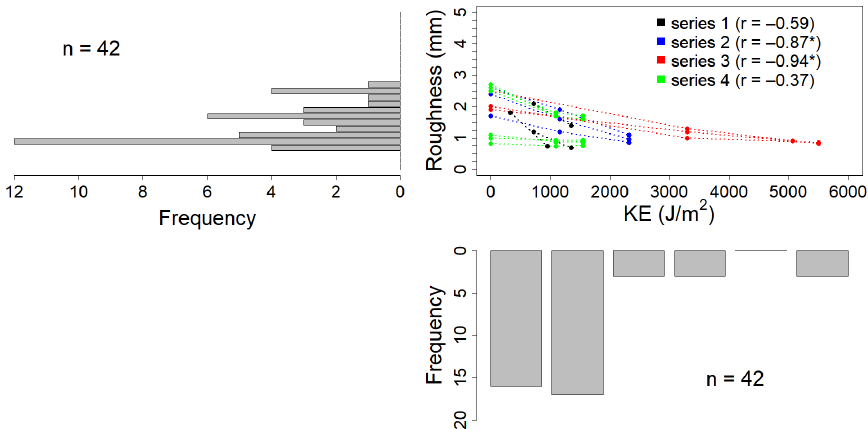
Figure 9. Scatterplot of KE in J/m 2 and measured roughness in mm of standard deviation, detailed for the 15 mm resolution. Data histograms are plotted side by side to the respective axes. The pertinence to the four data series is highlighted with colours. Correlation values with p < 0.05 are marked with *.